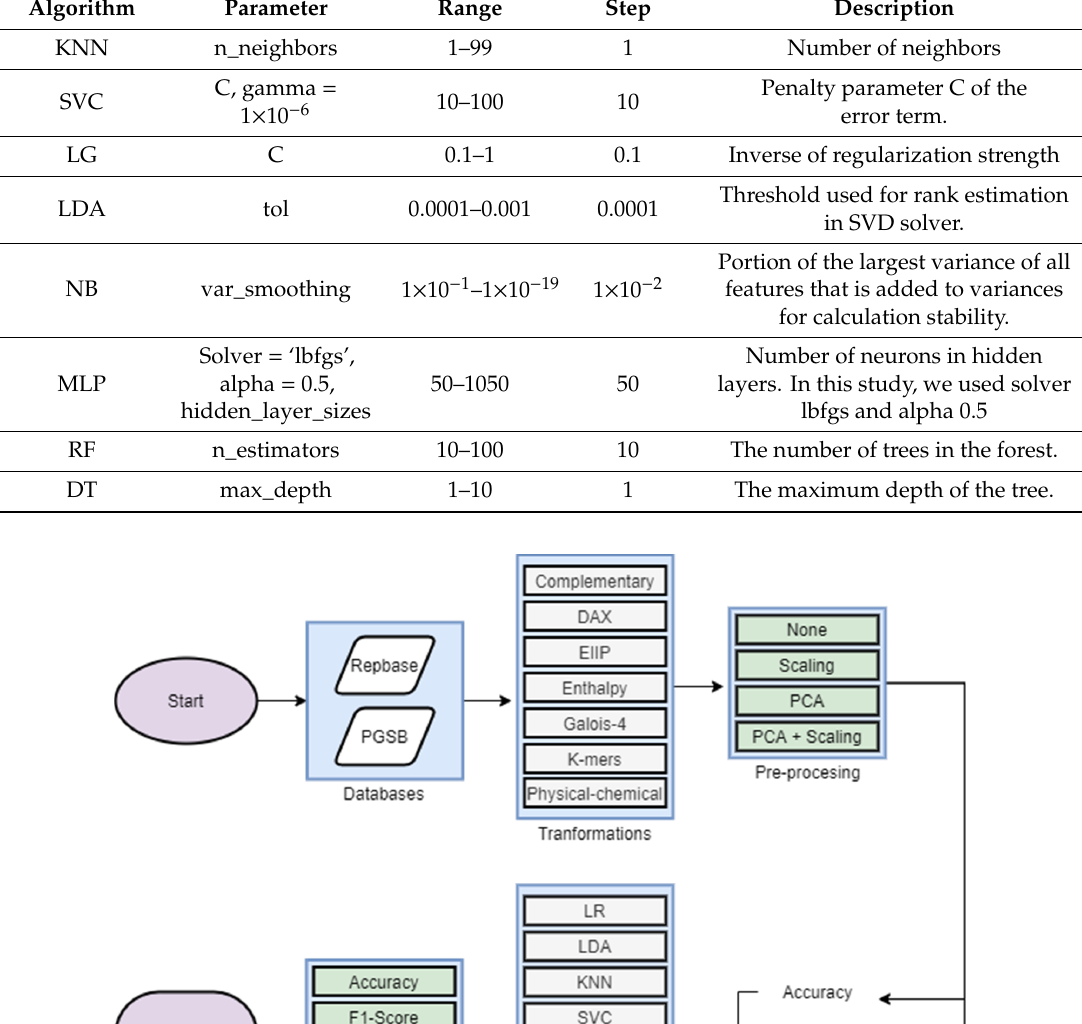
Table 3. Tested algorithm parameters .